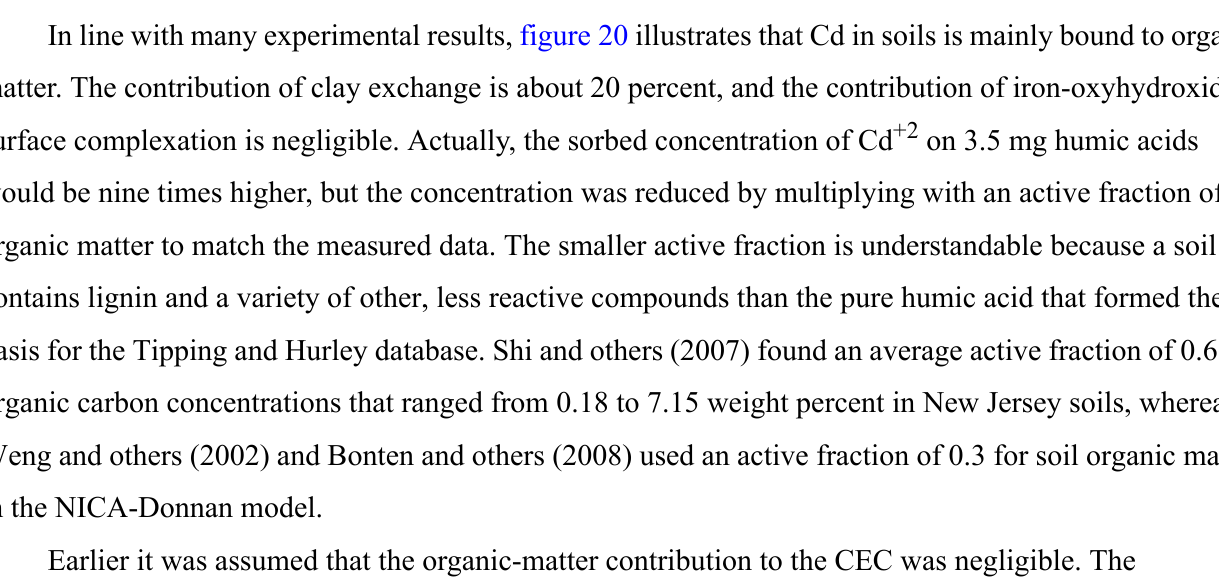
Figure 20. Measured sorption of Cd on loamy soil and calculated sorption on iron oxyhydroxides (“Hfo”), clay minerals (“X”), and organic matter (“HumicAcids”). TOTAL represents the sum of all sorbed